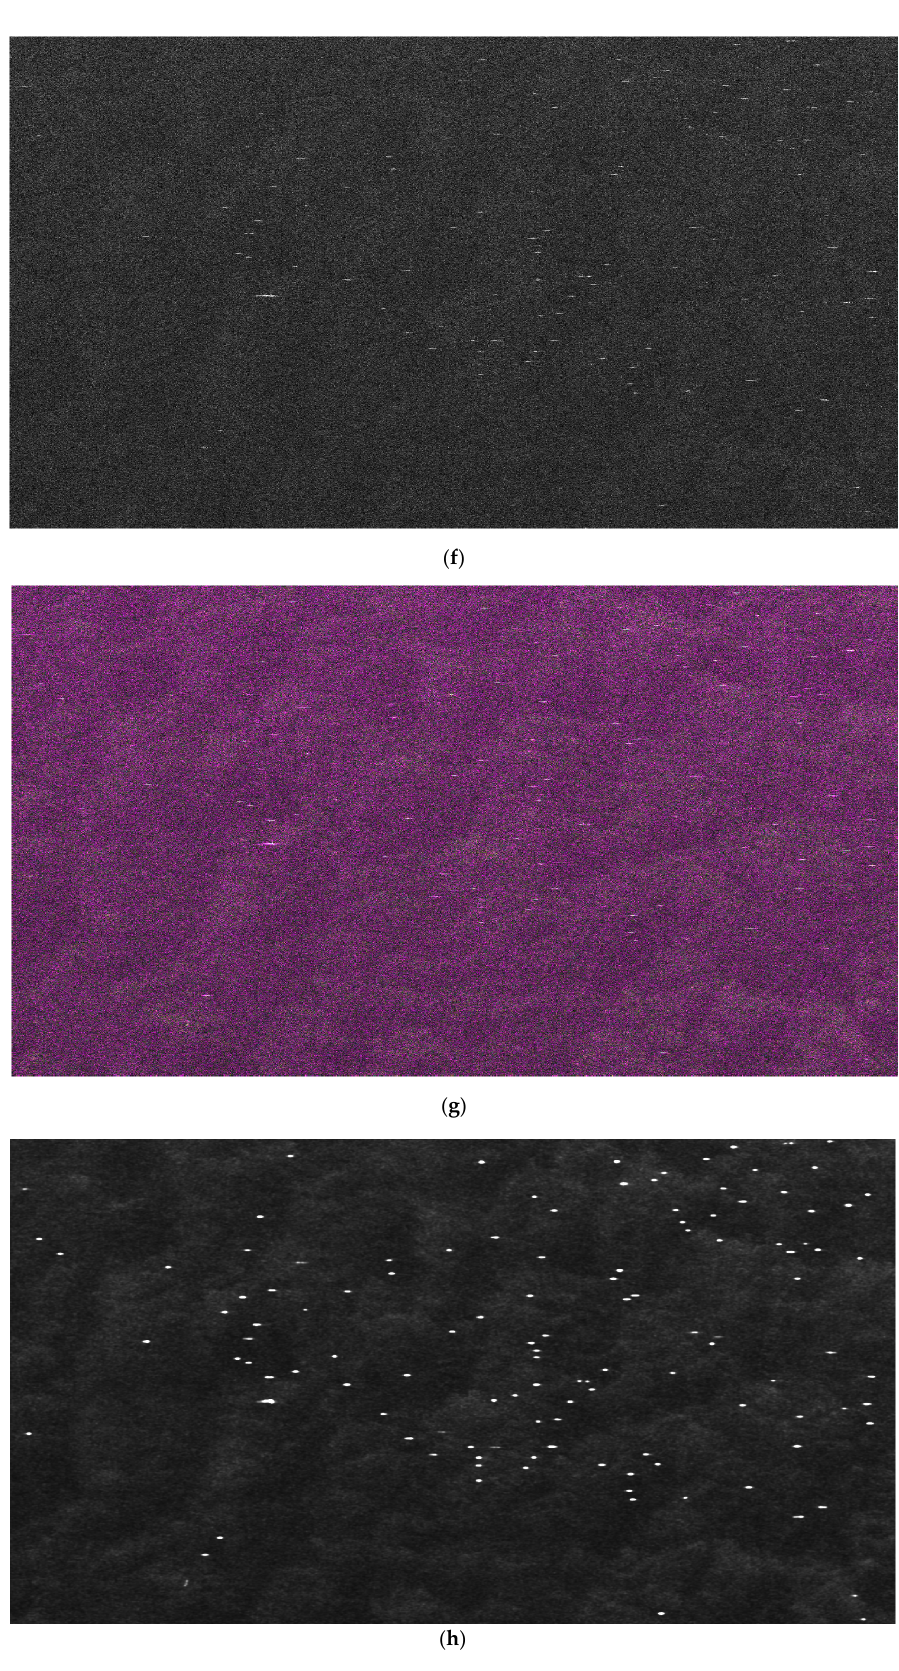
Figure 2. Data set 1: ( a ) HH amplitude; ( b ) HV amplitude; (c) pseudo color composed by R HH-HV  Figure2. Dataset1: ( a )HHamplitude; ( b )HVamplitude; (c) pseudocolorcomposedbyR = | HH − HV | , , G HV  G = | HV | , B = | HH | ; ( d ) reflection symmetry. Data set 2: ( e ) VH amplitude; ( f ) VV amplitude; ( g ) pseudo pseudo color composed by R VH-VV  color composed by R = | VH − VV | , G = | VH | , B = | VV | ; (h) reflection